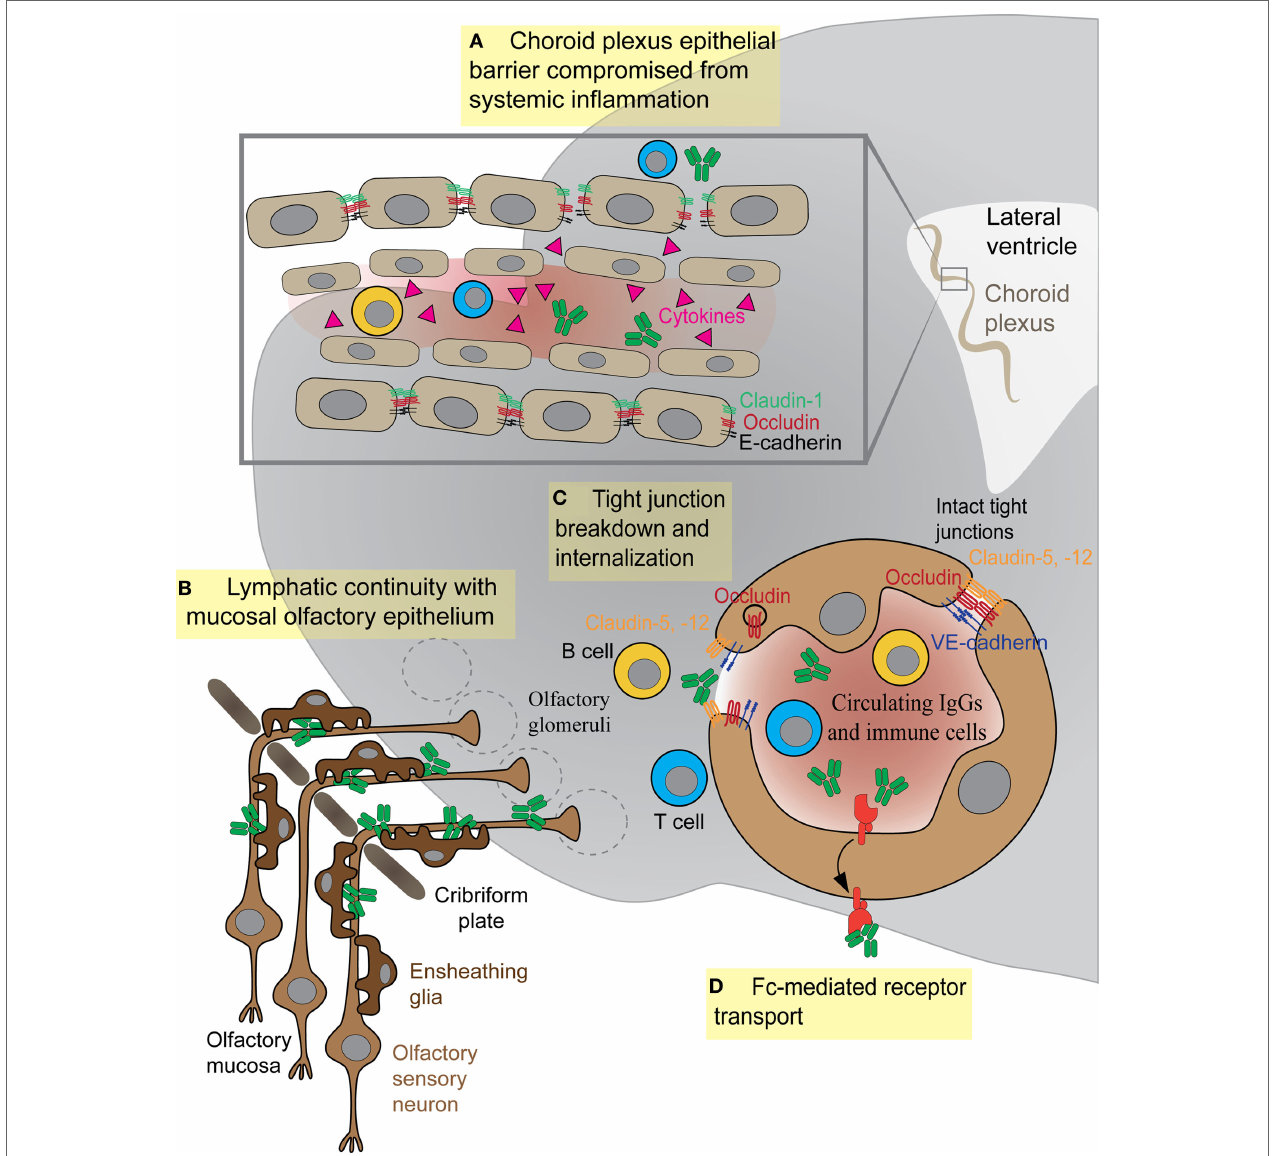
FiGURe 3 | Antibody and immune cell access to the brain parenchyma via four distinct routes . (A) Systemic cytokines break down tight junctions (TJs) within the brain–cerebrospinal fluid barrier to allow central nervous system (CNS) access of antibodies or immune cells. (B) Olfactory ensheathing glia facilitate transport of IgGs or immune cells along sensory axons exiting the olfactory mucosa. (C) Inflammatory cytokines in the bloodstream damage TJs between endothelial cells, thus allowing antibodies or immune cells (T or B cells) to enter the CNS. (D) F c receptor directionality reverses, shuttling IgG from vessels into brain parenchyma as in systemic lupus